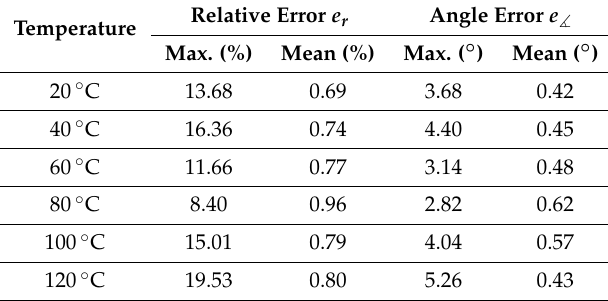
Table 9. Calculated errors by considering the corrected GMR characteristic at different